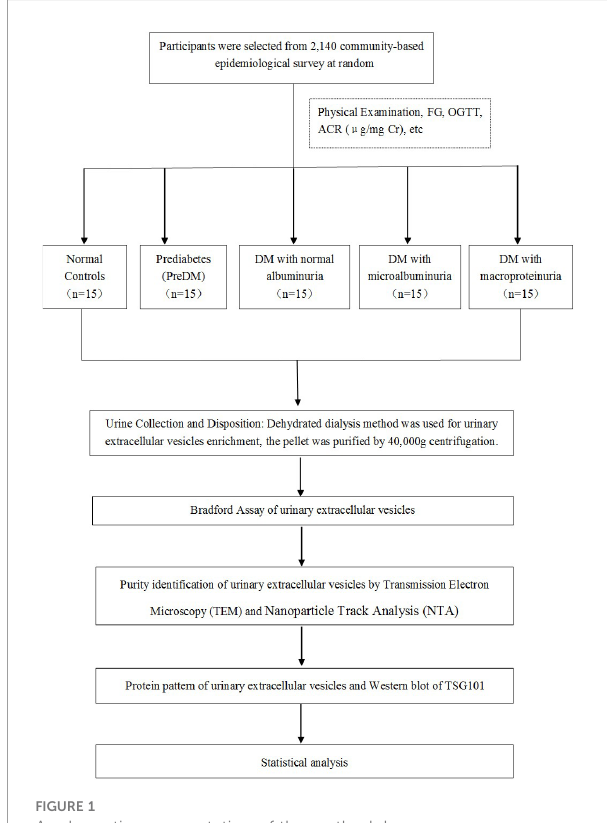
FIGURE 1 A schematic representation of the